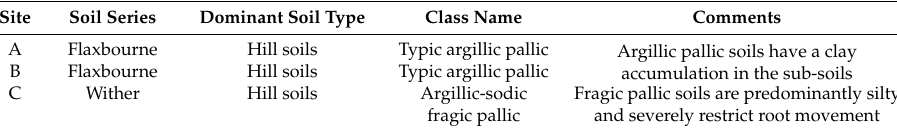
Table 2. Soil description of three sites according to Hewitt